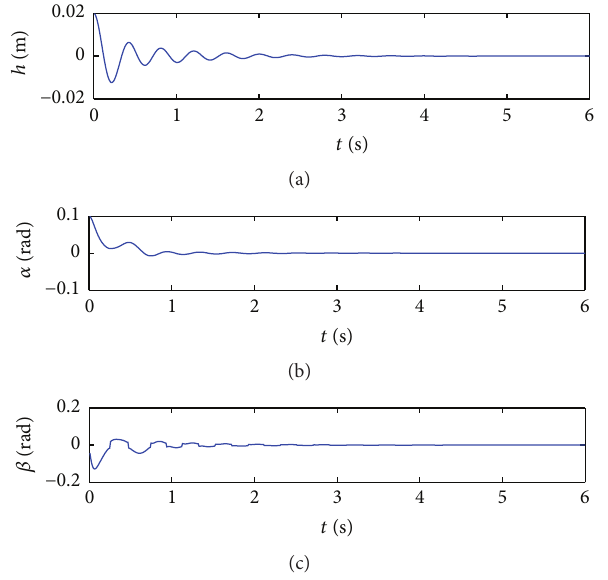
Figure 4: ILC control for triangular gust, 𝑤 0 = 0.7 , 𝑈 = 10 m/s: (a) plunge displacement ℎ (m); (b) pitch angle 𝛼 (rad); (c) control input 𝛽 (rad).